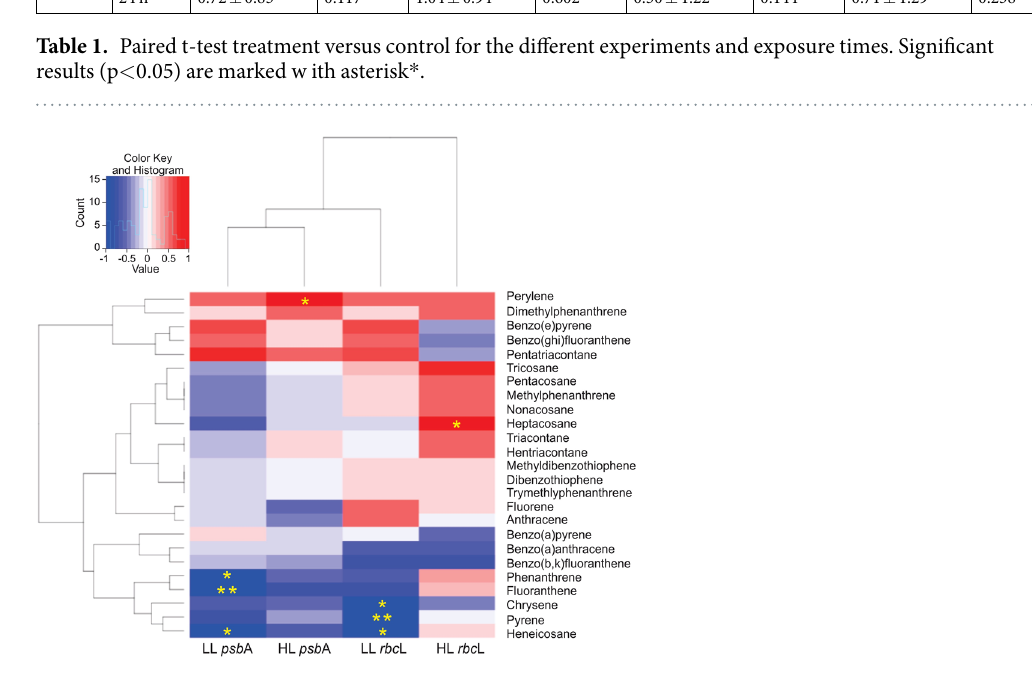
Figure 3. Correlations between changes in gene expression after 2 h exposure and the increase on concentration of the different components of the CM mixtures. Both magnitudes are expressed as fold changes (treated versus control). A, Spearman correlation heatmap. Significant correlations are indicated by asterisks ( * p < 0.05; ** p < 0.01). B) Double log plots between changes in rbc L LL and psb A LL mRNA levels (top and bottom X-axis, respectively) and in the concentration of different components (Y-axis), expressed both as fold changes (Treated versus Controls). Regression lines and the corresponding R 2 values are